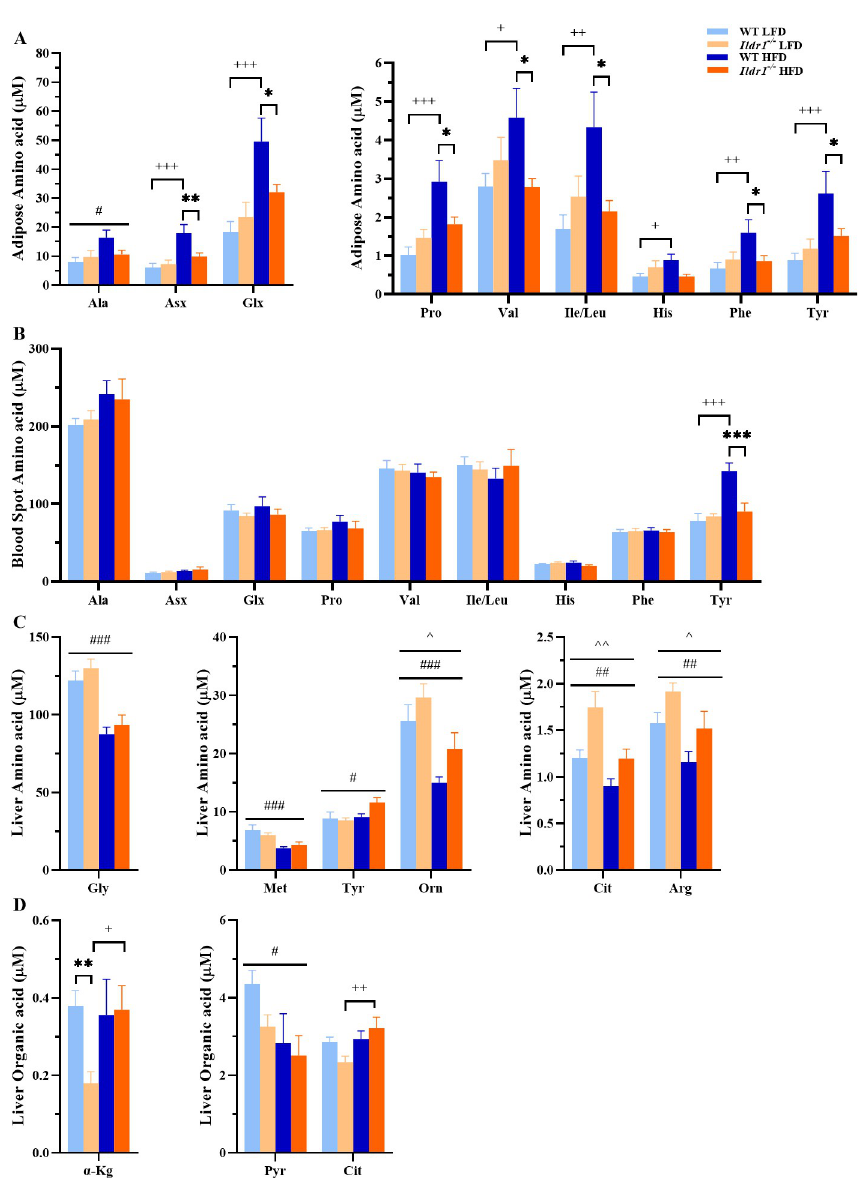
Fig 12. Metabolite profiles of wild-type (WT) and Idlr1 -/- mice fed a low fat diet (LFD) and high fat diet (A) Adipose amino acid profile for Ala: diet [F(1,22) = 4.436, P = 0.047]; for Asx: diet [F(1,22) = 14.686, P < 0.001], genotype by diet [F(1,22) = 6.057, P = 0.022]; and for Glx: diet [F(1,22) = 13.319, P = 0.001], genotype by diet [F(1,22) = 4.295, P = 0.050]; for Pro: diet [F(1,22) = 12.128, P = 0.002], genotype by diet [F(1,22) = 5.753, P = 0.025]; for Val: genotype by diet [F(1,22) = 4.971, P = 0.036]; Ile/Leu: genotype by diet [F(1,22) = 6.604, P = 0.017]; for His: genotype by diet [F (1,22) = 5.645, P = 0.027]; Phe: genotype by diet [F(1,22) = 4.495, P = 0.045]; and for Tyr: diet [F(1,22) = 9.309, P = 0.006], genotype by diet [F(1,22) = 4.351, P = 0.049]. (B) Blood spot amino acid profile for Tyr: genotype [F(1,23) = 7.552, P = 0.011], diet [F(1,23) = 17.184, P < 0.001], genotype by diet [F(1,23) = 11.497, P = 0.003]. (C) Liver amino acid profile for Gly: diet [F(1,23) = 35.189, P < 0.001]; for Met: diet [F(1,23) = 16.715, P < 0.001]; for Tyr: diet [F(1,23) = 4.528, P = 0.044]; for Orn: genotype [F(1,23) = 4.192, P = 0.052], diet [F(1,23) = 16.240, P < 0.001]; for Cit: genotype [F (1,23) = 10.913, P = 0.003], diet [F(1,23) = 11.373, P = 0.003]; and for Arg: genotype [F(1,23) = 7.633, P = 0.011], diet [F (1,23) = 10.412, P = 0.004]. (D) Liver organic acid profile for α Kg: genotype by diet [F(1,21) = 4.876, P = 0.038]; for Pyr: diet [F(1,23) = 5.571, P = 0.027], and for Cit: diet [F(1,23) = 5.857, P = 0.024], genotype by diet [F(1,23) = 4.227, P = 0.051]. n = 5–8 samples/group. � P < 0.05, �� P < 0.01, ��� P < 0.001, WT vs . Ildr1 -/- within diet; +P < 0.05, ++P < 0.01, + ++P < 0.001, low vs . high fat diet within genotype; ^P < 0.05, ^^P < 0.01, overall genotype effect; #P < 0.05, ##0.01, ###P < 0.001, overall diet